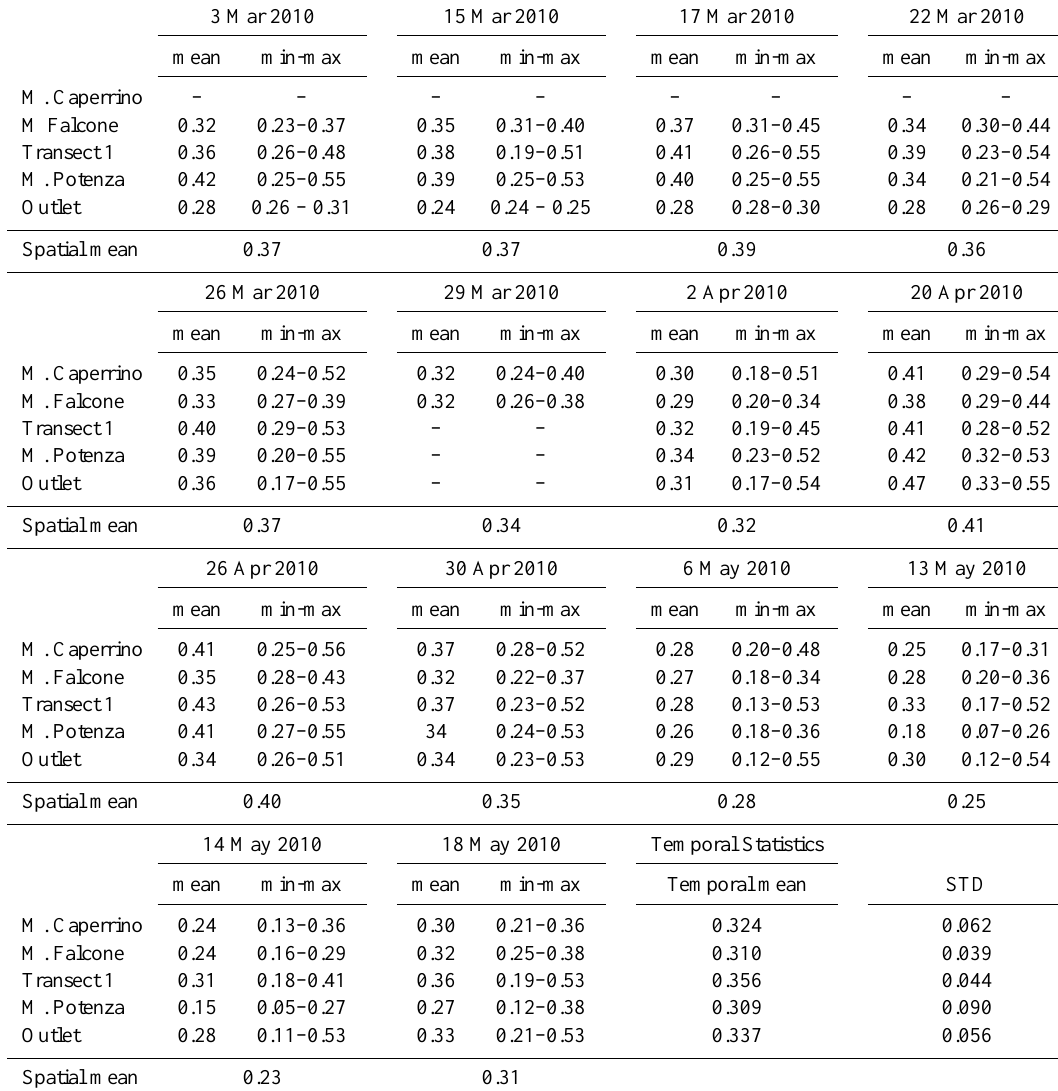
Table 1. Summary of the SM measurements m 3 m − 3 obtained using the portable TDR during the period 3 March 2010 to 18 May